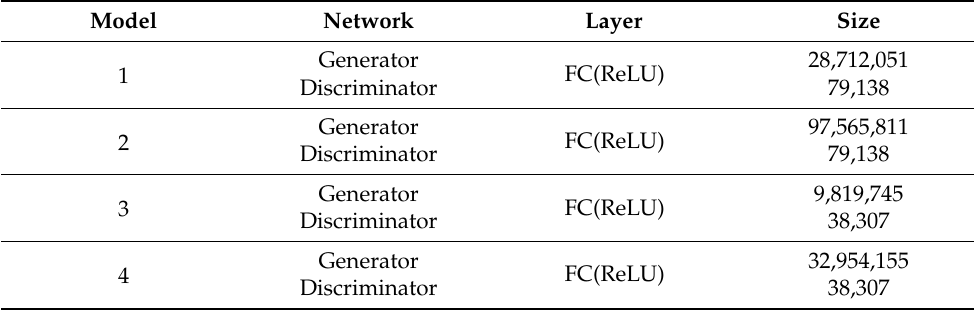
Table 6. The Sizes of The RGN Models 1 to